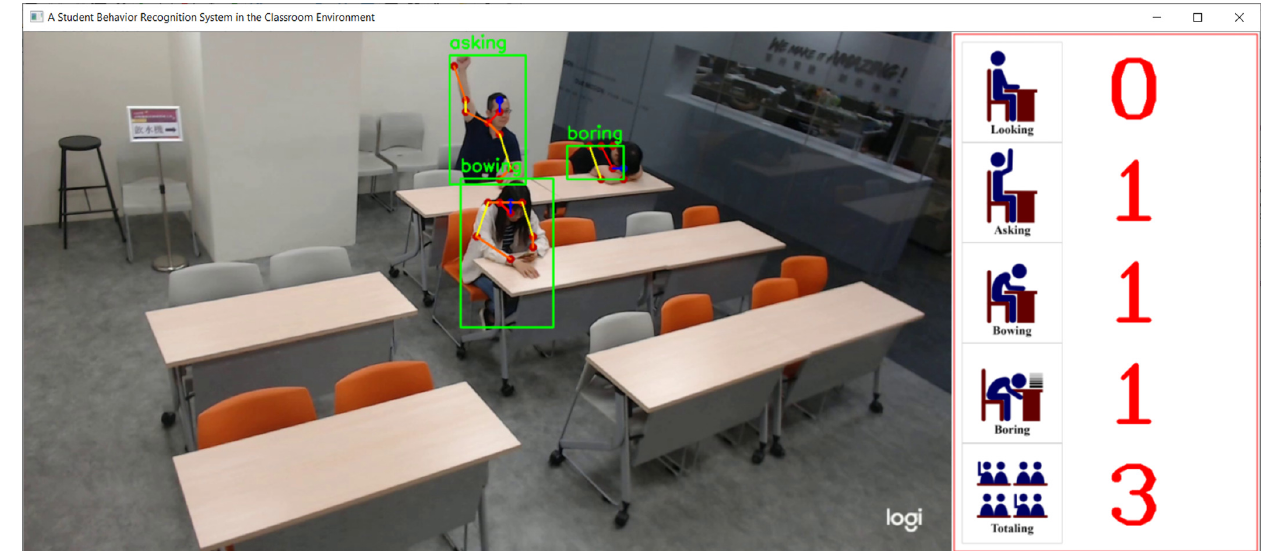
Figure 8. User interface of the proposed system.